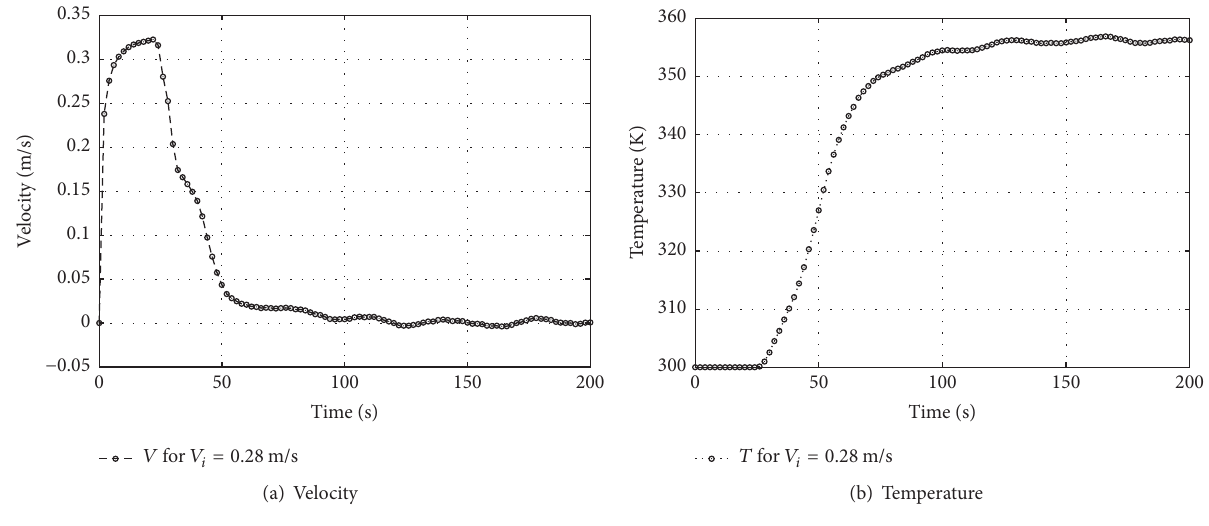
Figure 13: Upstream conditions for 𝑉 𝑖 = 0.28 m/s with methanol as